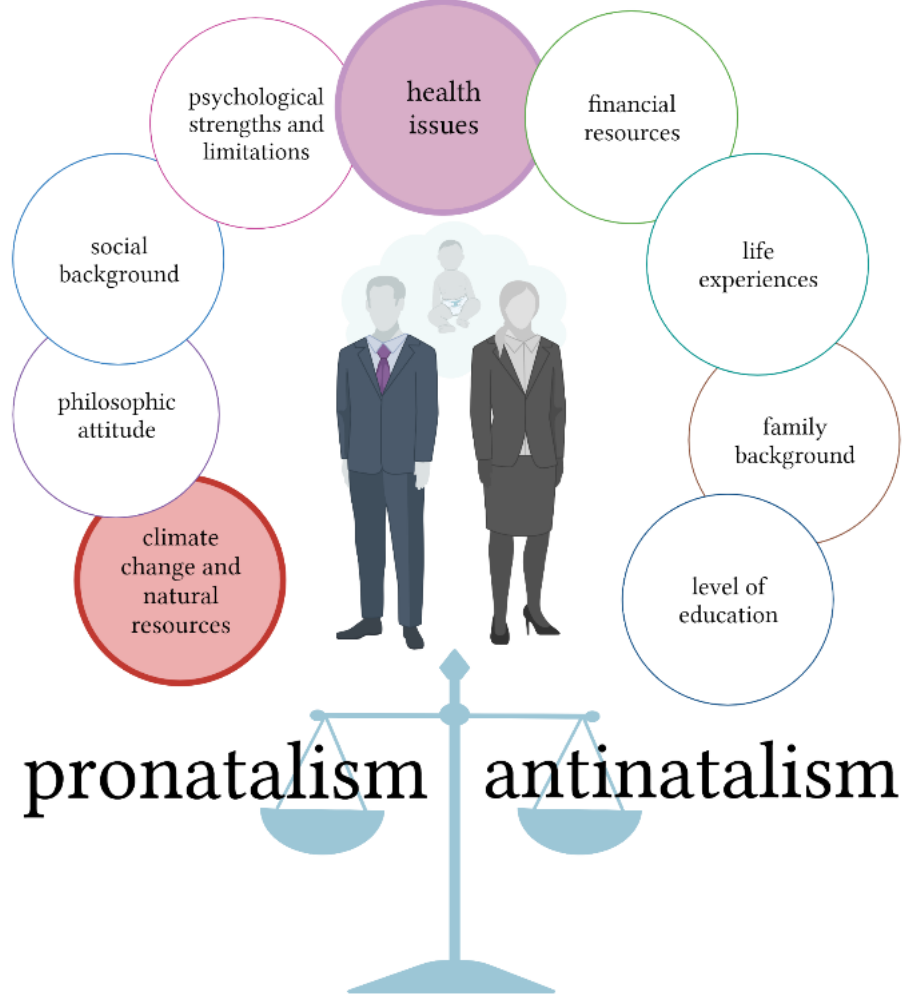
Figure 1. The multifaceted nature of antinatalism. Antinatalism is influenced by a variety of different factors, such as environmental changes, health care issues, philosophic attitude, social back- ground, psychological aspects, financial resources, life experiences, family background, and level of education.